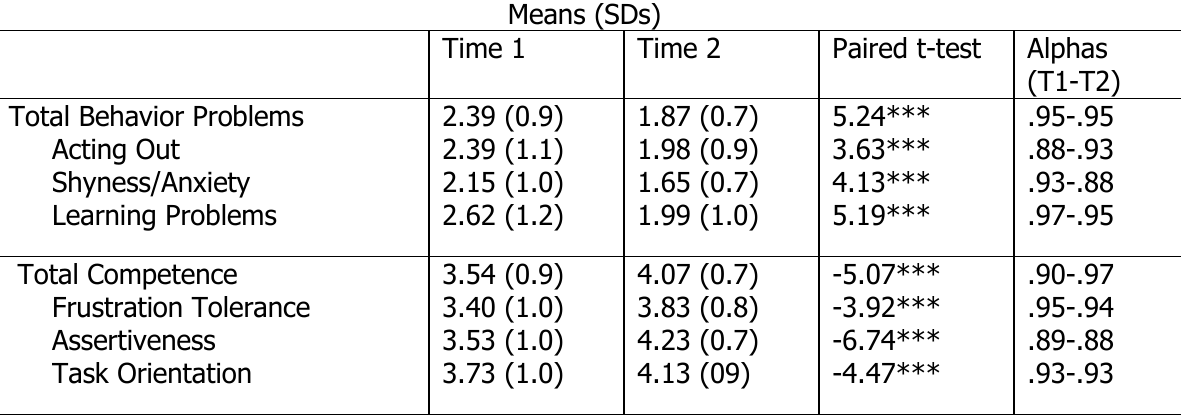
Teacher Ratings of Chile Competence and Behavior Problems (N=36)